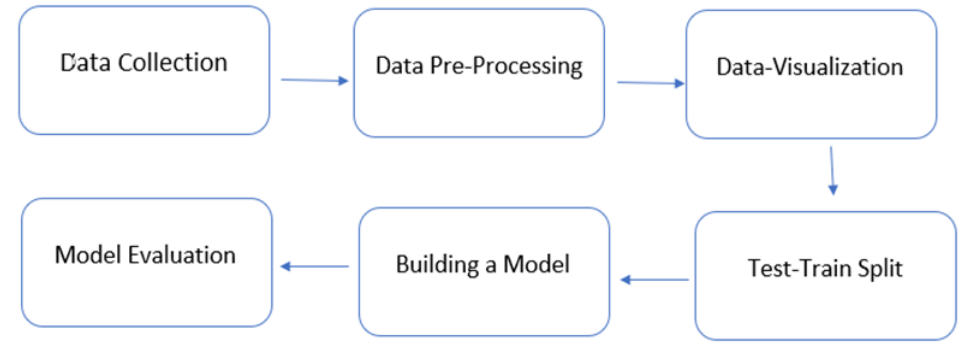
Figure 1. Methodology of the study.